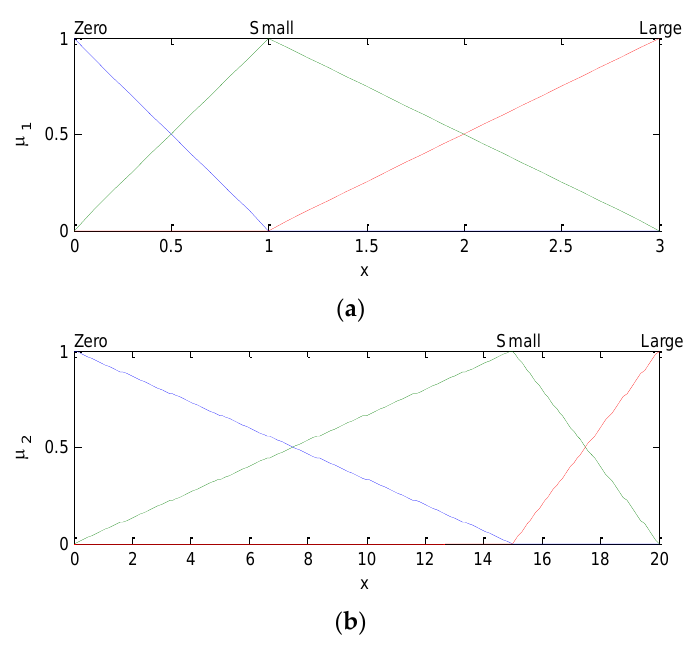
Figure 2. Membership functions of input fuzzy variables µ 1 ( a ) and µ 2 ( b ).